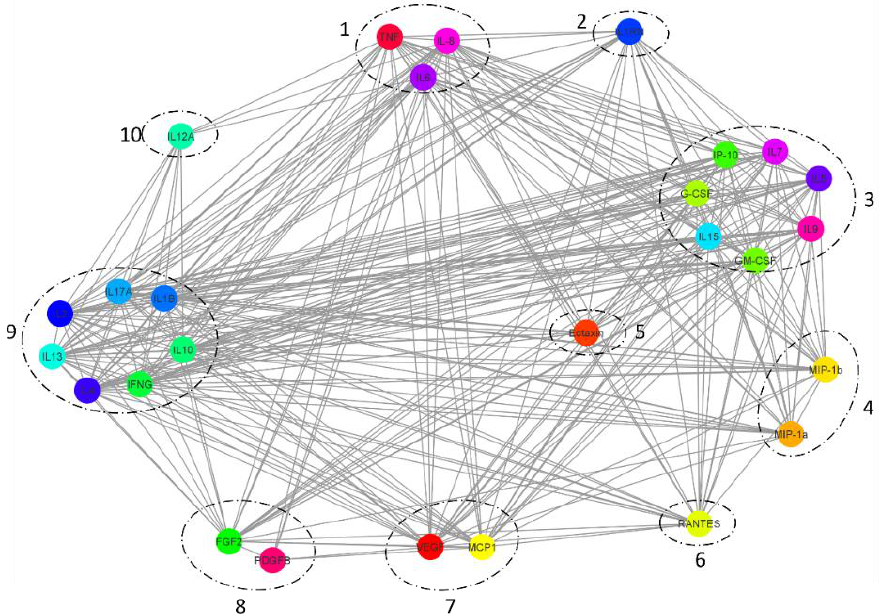
Figure 6. Cytokine interaction network for 27-plex, mapping high interactivity among IL-1b, IL-1rn, IL-2, IL-4, IL-5, IL-6, IL-7, IL-8, IL-9, IL-10, IL-12, IL-13, IL-15, IL-17A, Eotaxin, FGF-basic, G-CSF, GM-CSF, IFN- γ , IP-10, MCP1, MIP-1a, MIP-1b, PDGFB, RANTES, TNF- α , and VEGF, with 307 interactions and an average of 22.7 interactions per cytokine. Ten distinct groups are circled on the basis of the interactivity similarity of node clusters across the Table 1. Biological annotation for cytokines and chemokines.